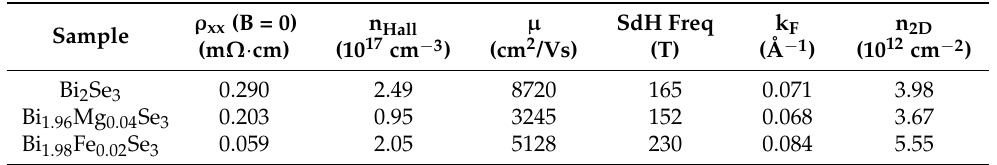
Figure 7. The magnetoresistance of Bi 2 Se 3 , Bi 1.96 Mg 0.04 Se 3 and Bi 1.98 Fe 0.02 Se 3 at 200 mK. The solid lines are for B perpendicular to the a-b plane and the dashed lines are for B parallel to the a-b plane. The insets show the transverse resistivity ( ρ xy ). Table 3. The estimated parameters from the magnetoresistance, Hall effect and SdH oscillations obtained at 200 mK.